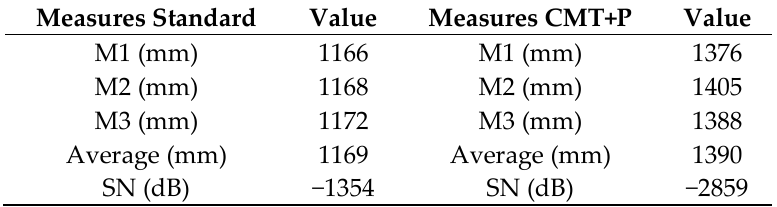
Table 5. Bead reinforcement values obtained in the confirmation experimental